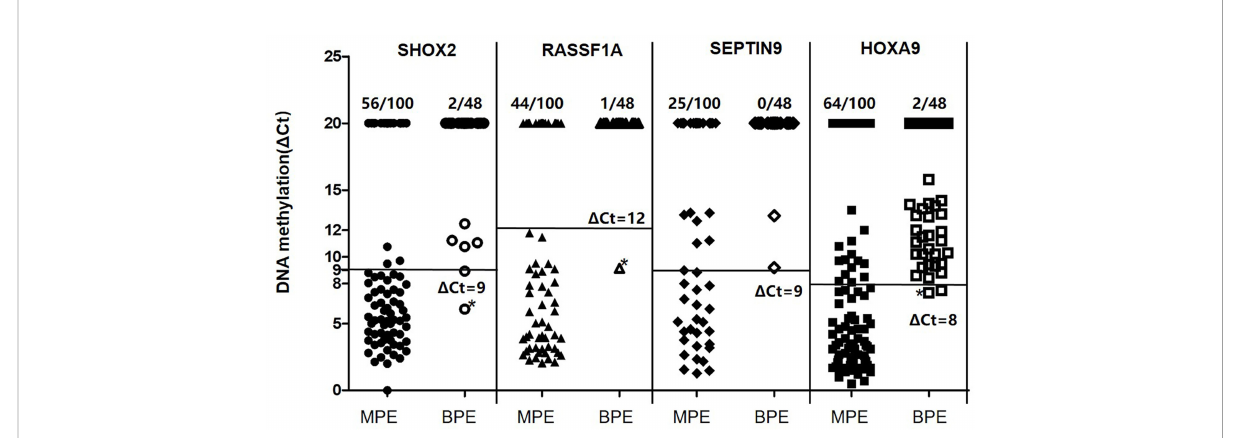
FIGURE 2 Quantitative analysis of SHOX2, RASSF1A, SEPTIN9 and HOXA9 DNA methylation in MPE (n = 100) and BPE (n = 48) specimens. MPE, malignant pleural effusion; BPE, benign pleural effusion; SHOX2, short stature homeobox gene two; RASSF1A, RAS association domain family 1, isoform A; HOXA9, homeobox A9; SEPTIN9, Septin